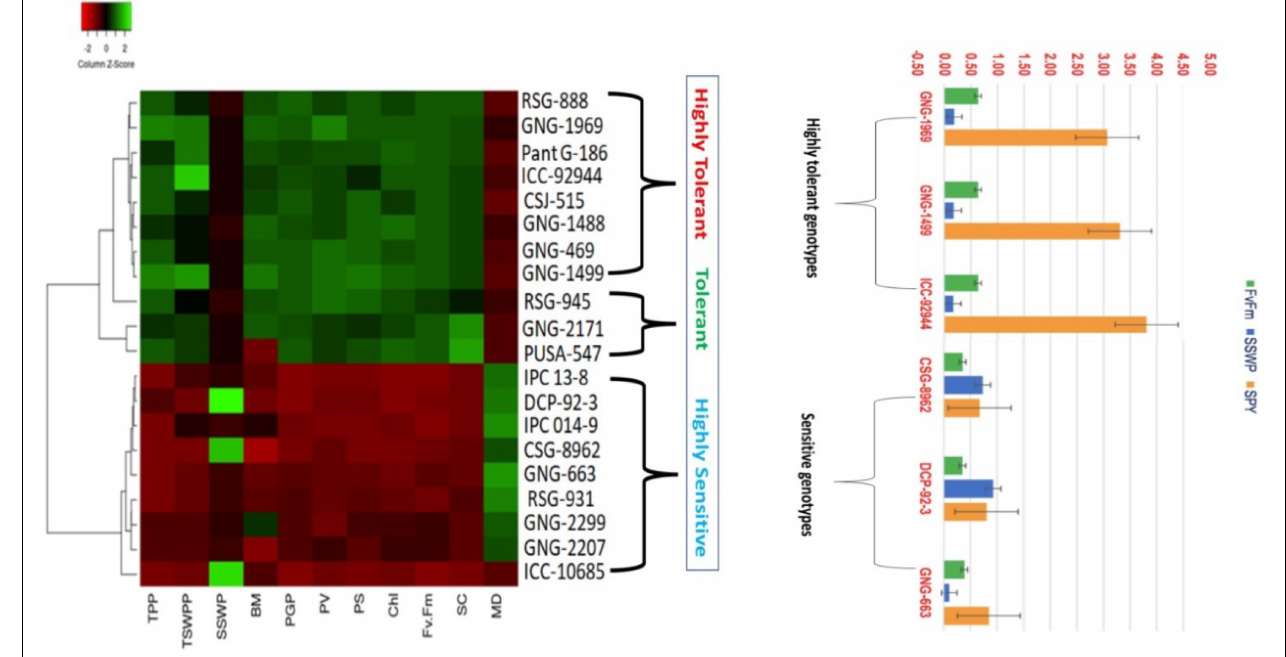
FIGURE 10 | Heat map based on the response of chickpea genotypes to heat stress in a growth